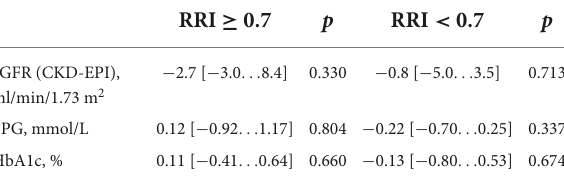
TABLE 3 Changes in estimated glomerular filtration rate (eGFR), fasting plasma glucose (FPG), and glycosylated hemoglobin (HbA1c) at 12 months after renal denervation (RDN).